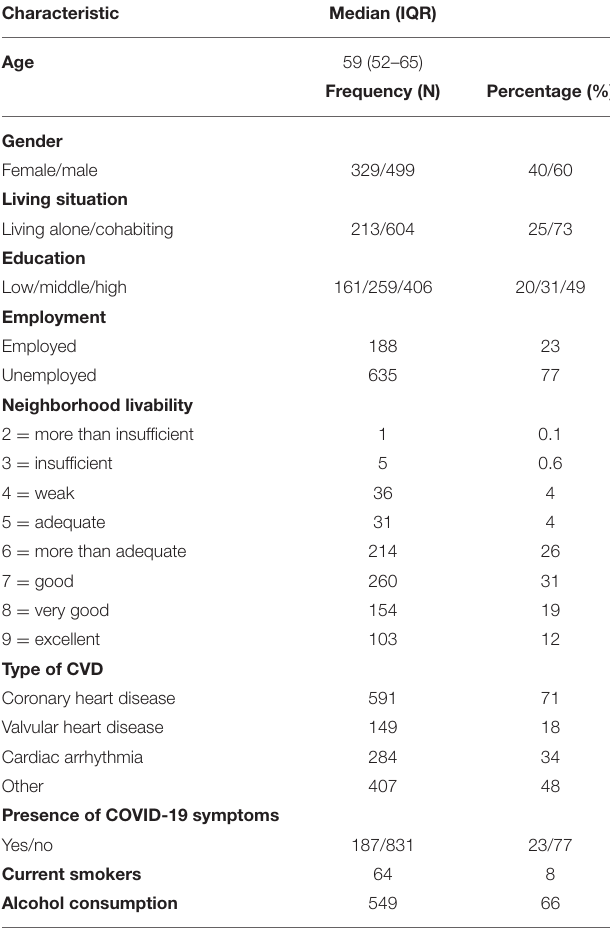
TABLE 1 | Sociodemographic and disease characteristics of the sample (N =